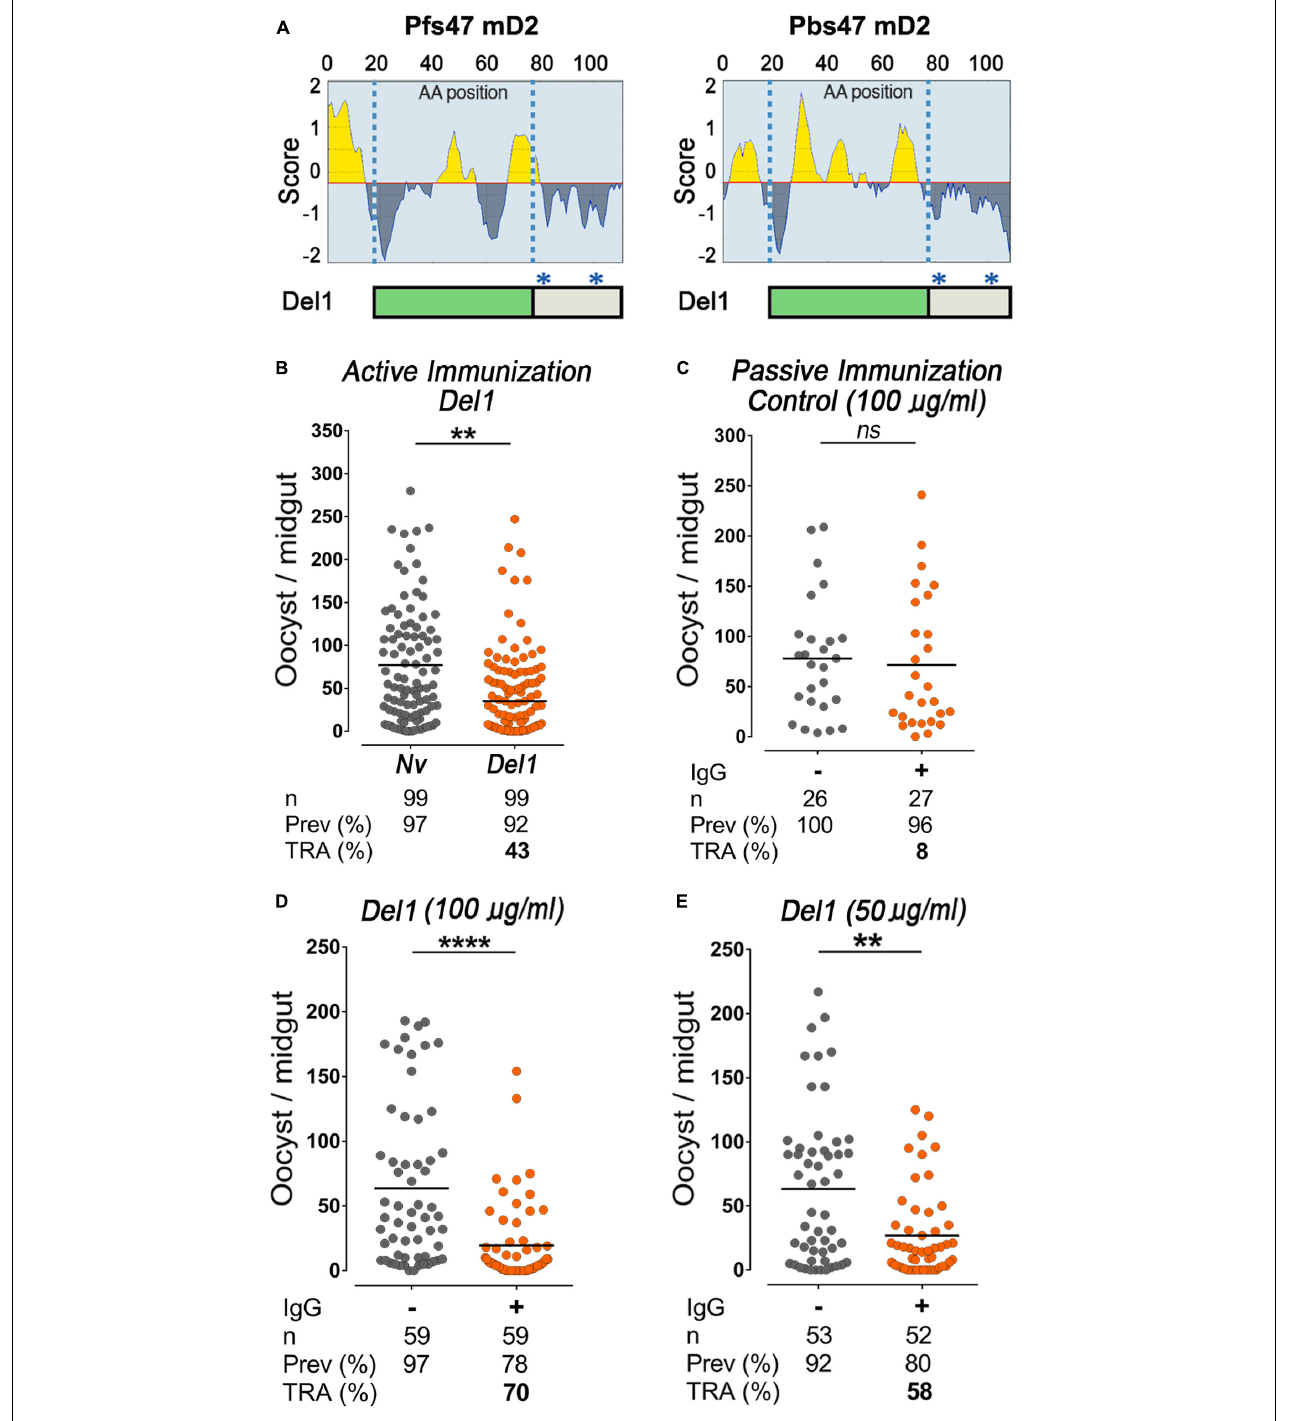
FIGURE 2 | Epitope analysis of Pbs47-mD2, immunogenicity, and transmission-reducing activity of Del1. (A) Top, Linear B-cell epitopes prediction of Pfs47-mD2 (left) and Pbs47-mD2 (right) based on the Bepipred Program; Bottom, schematic representation of Pbs47-mD2 deletion, black asterisks indicate positions where cysteine residues were substituted with alanine. (B) Mean TRA of Del1 following direct mosquito feeding on mice, n = 4. (C) TRA following direct mosquito feeding on mice passively immunized with 100 µ g/mL of naïve IgG. (D) TRA of Del1 following direct mosquito feeding on individual mice passively immunized with 100 µ g/mL and (E) 50 µ g/mL of Del1 purified IgG, respectively. Each dot represents the number of oocysts in individual mosquito and the lines indicate the medians per group. Number of mosquitoes dissected (n); Infection prevalence (Prev); Transmission-reducing activity (TRA) as percent inhibition of infection intensity relative to naïve control mice. This data represents the overall result from n = 2 replicates. Medians were compared using the Mann–Whitney test: ns, no significant difference; ns non-significant; ** P < 0.01; **** P < 0.0001.